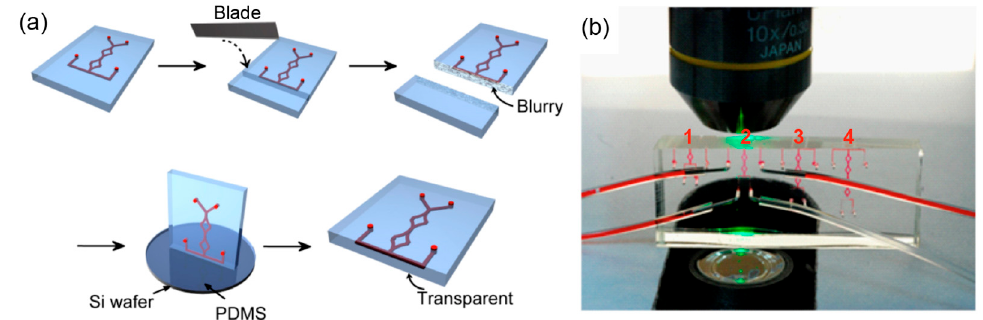
Figure 2. Method for high-resolution imaging of the fluid mixing distribution on cross-sections of the outlet of serial mixing cycles with high resolution. ( a ) Procedures to make the side surface of the chip optically transparent for observing the mixer outlet cross-sections. The extra marginal PDMS near the outlet was cut and removed. The exposed blurry surface was further attached to a thin layer of uncured PDMS. After the crosslinking, the chip was peeled off from the wafer with a transparent outlet surface exposed. ( b ) Setup for imaging the cross-section of the chip’s channel outlets of the first four cycle numbers (red numbers) with confocal microscopy.